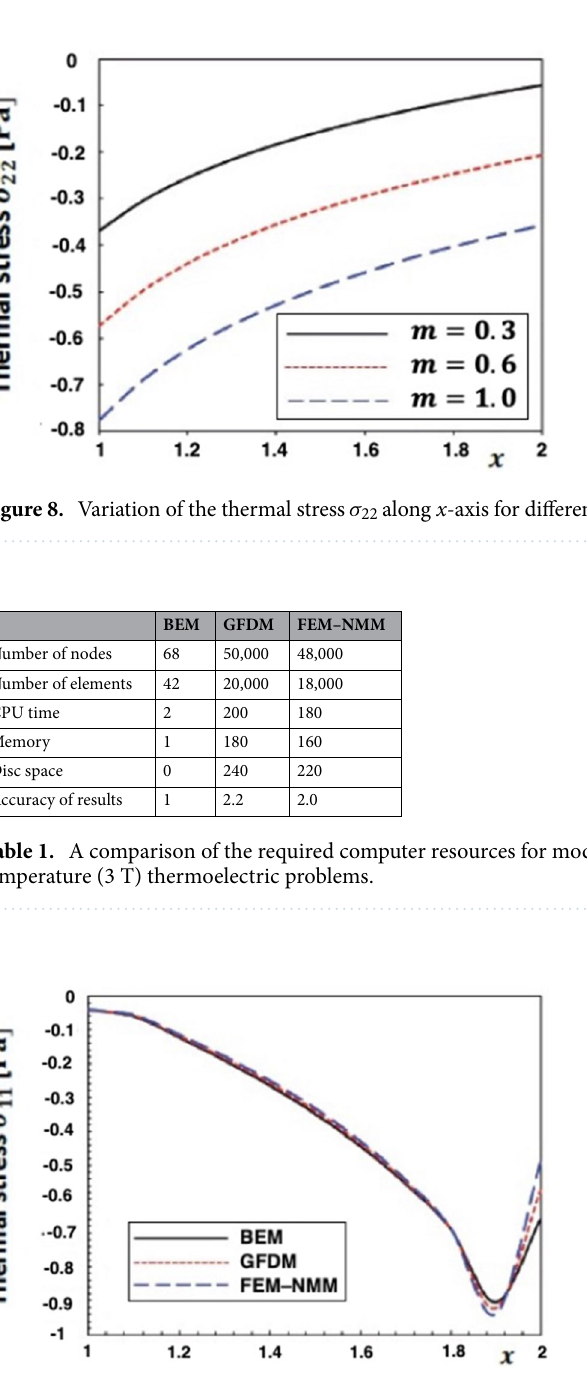
Figure 9. Variation of the special case thermal stress σ 11 along x -axis for BEM, GFDM and FEM–NMM ( a = 0.6, m = 0.0 )